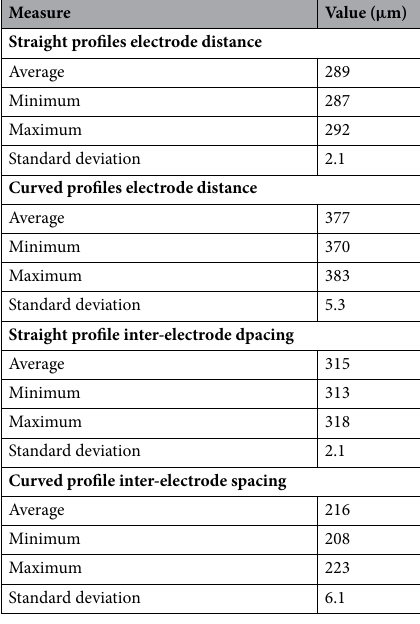
Table 1. Experimental resolution of screen templating through laser engraving